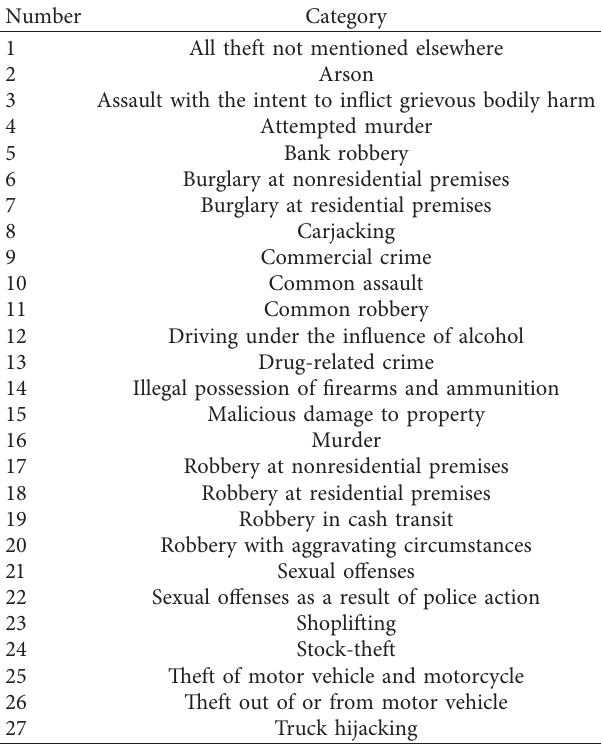
Figure 1: Cross-industry standard process for data mining (CRISP-DM). Table 1: Crime